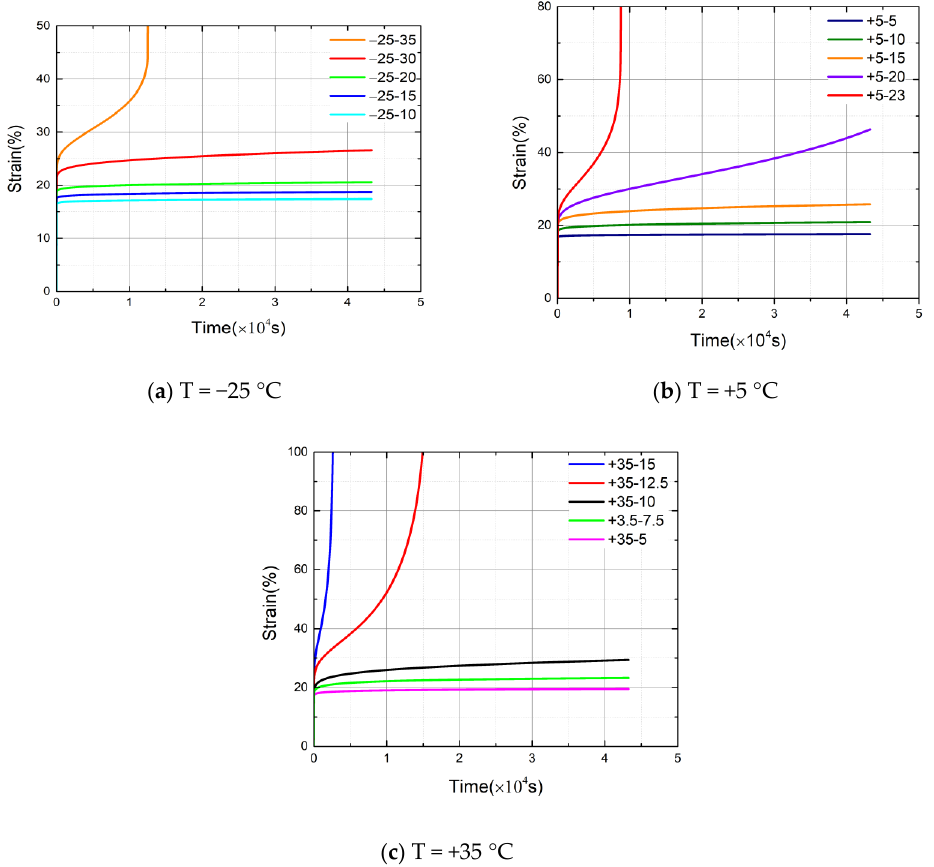
Figure 7. ( a ) Creep curves under different stress levels at T = − 25 ◦ C. ( b ) Creep curves under different stress levels at T = +5 ◦ C. ( c ) Creep curves under different stress levels at T = +35 ◦ C.